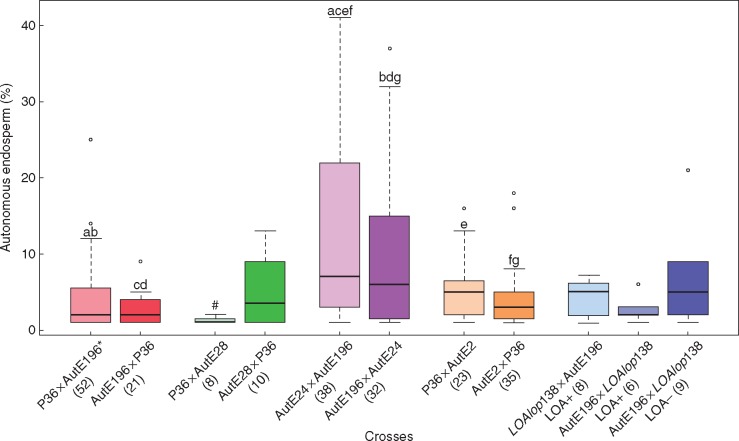
Box-and-whisker diagram for the proportion of ovules with autonomous endosperm in populations from various crosses. Boxes represent first and third quartiles, and the band inside each box indicates the median. Whiskers correspond to 95 % confidence intervals. Outliers are represented by circles. The number of progeny exhibiting the autonomous endosperm trait is shown in parentheses beneath each cross. The statistical significance (P < 0·05) of differences in autonomous endosperm expressivities between different crosses was determined by the Mann–Whitney U-test and is shown by paired letters above relevant cross populations. #This cross was not included in quantitative statistical analysis of autonomous endosperm because of a high frequency of embryo sac abortion that was potentially confounding. *This cross was reported previously (Ogawa et al., 2013). LOA+ and LOA– depict progeny that are aposporous and non-aposporous, respectively.